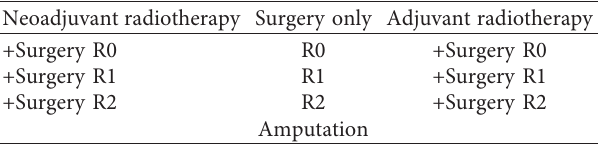
Table 2: Patient demographics.